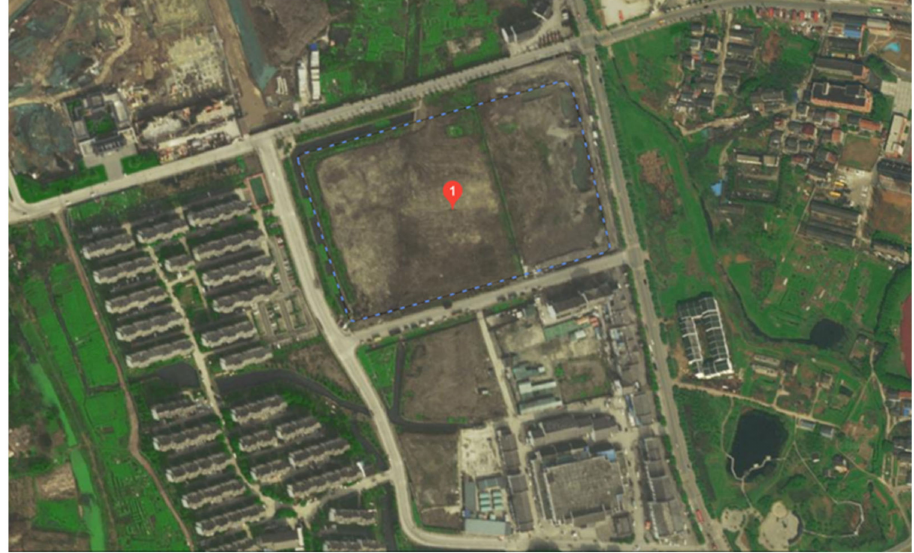
Figure 6. The exact location of Plot NO.2019G83.